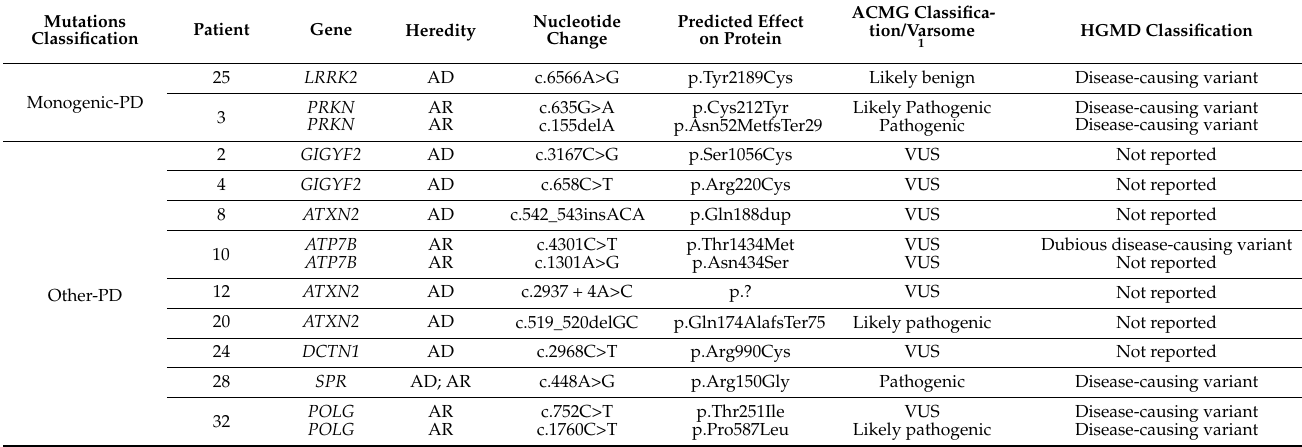
Table 1. Identification of variants in PD-associated